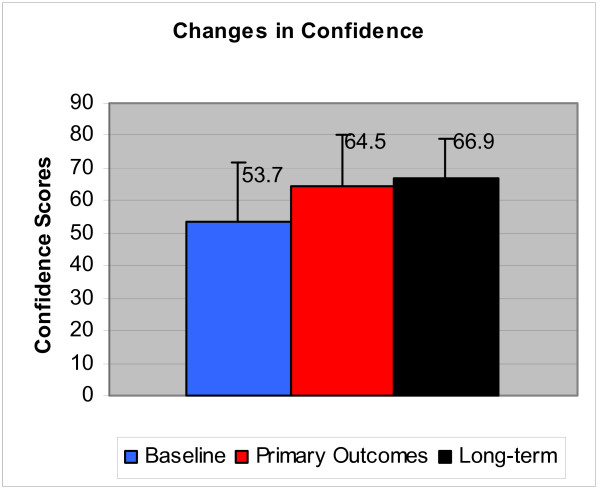
Changes in Confidence. • Baseline to Long-term Outcomes P-value < 0.001 (determined by Wilcoxon). • Primary Outcomes to Long-term Outcomes P-value Non-significant.